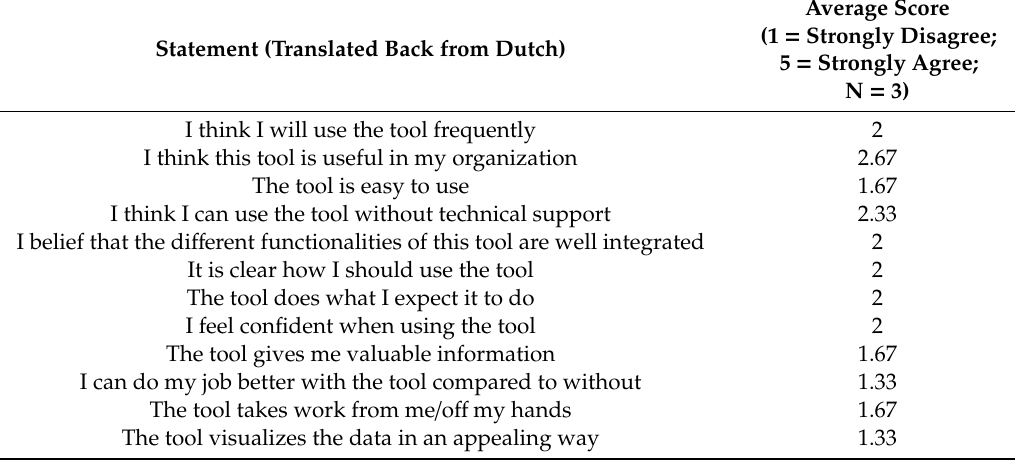
Table 1. Results